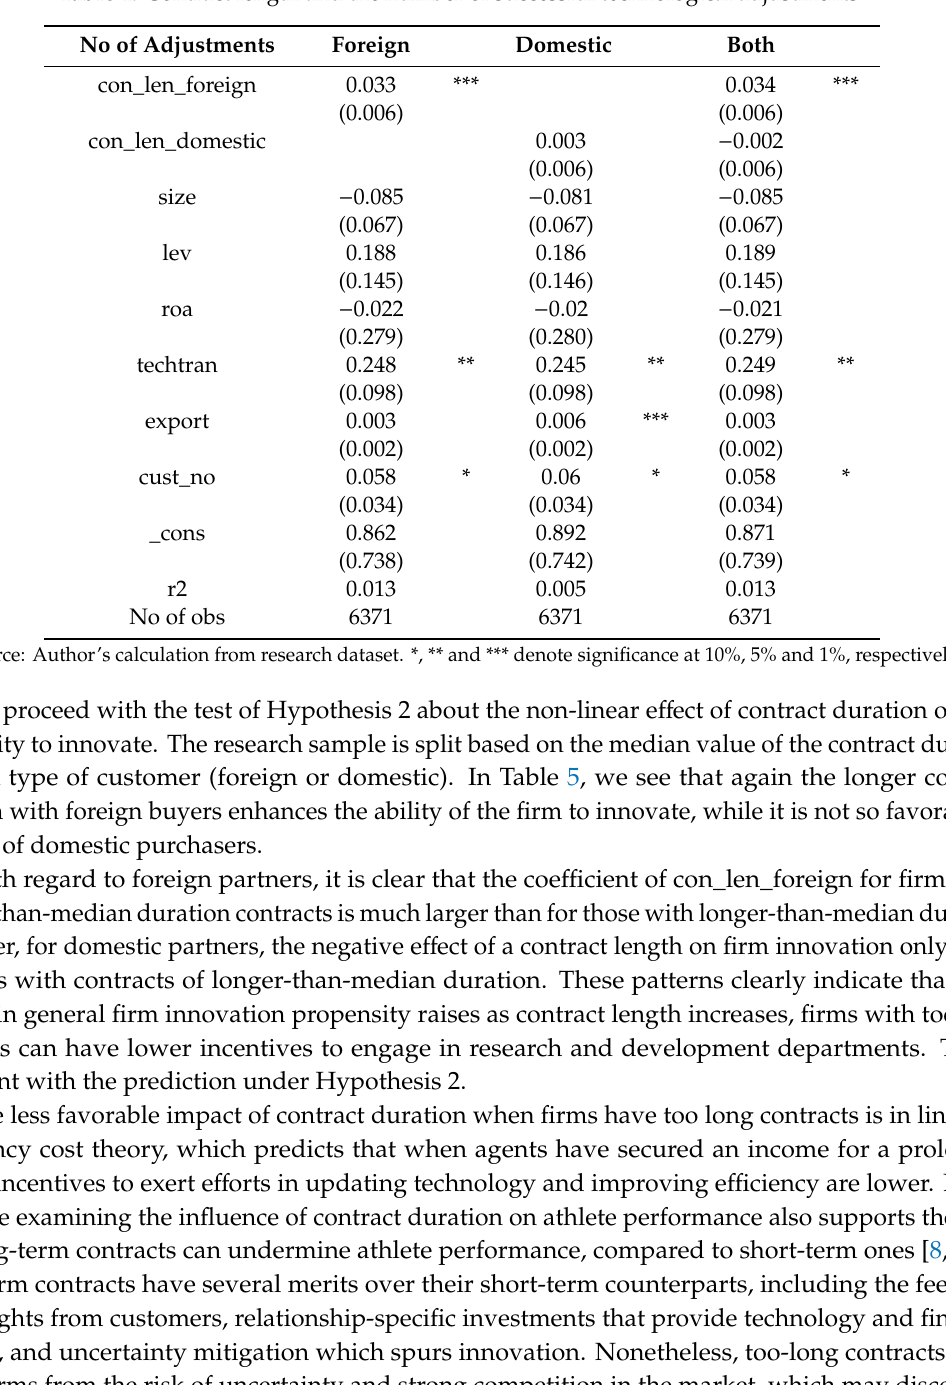
Table 4. Contract length and the number of successful technological